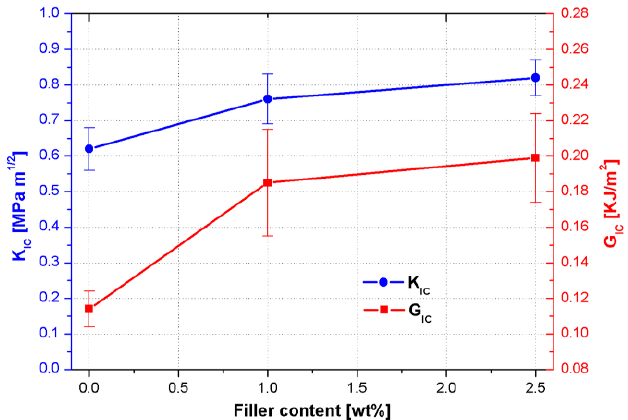
Table 4. Effect of CSNPs content on the nanocomposites fracture toughness. Sample